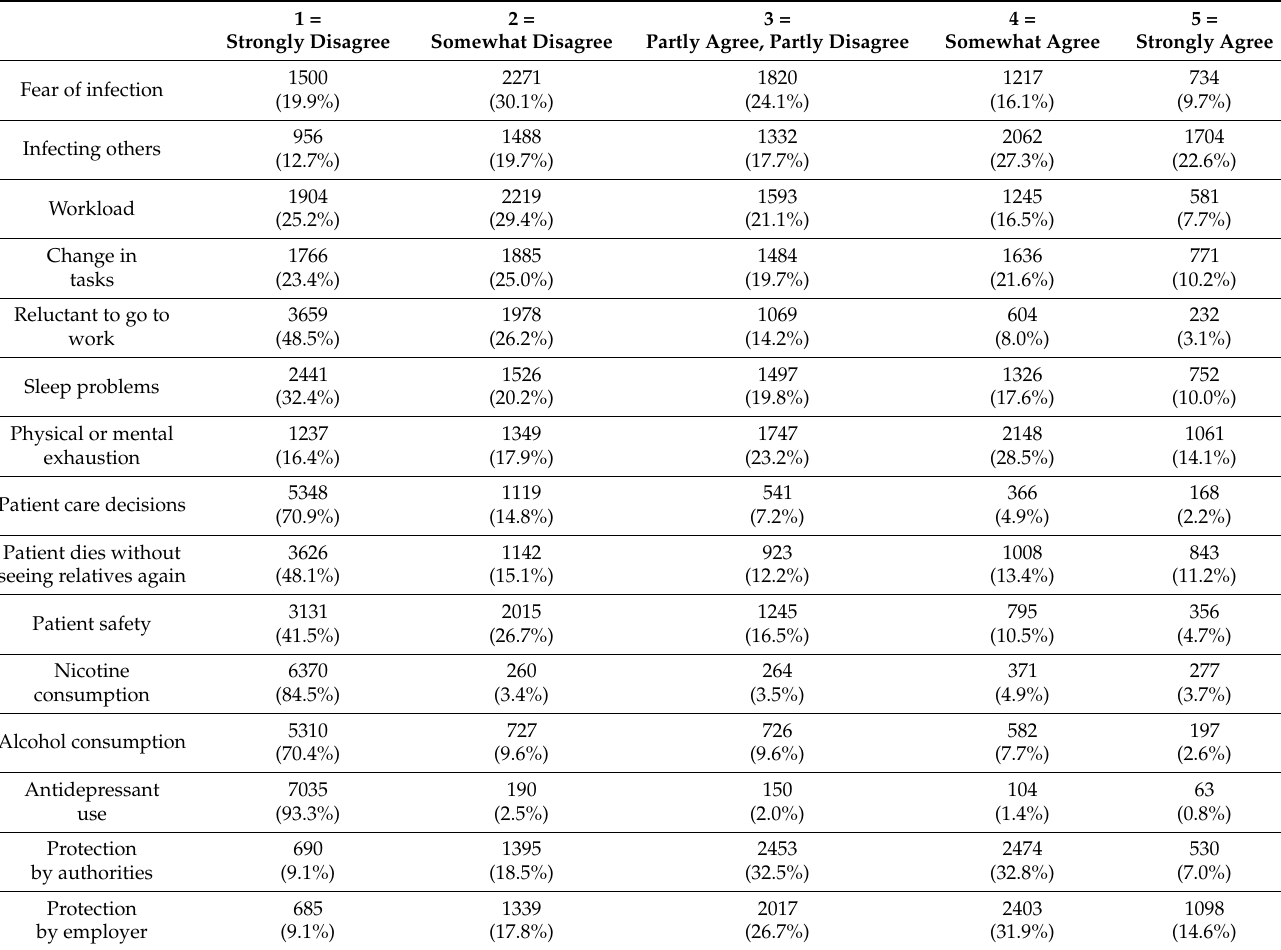
Table 3. Distribution of response options on COVID-19-associated problems and protective factors (reported as n (%)).